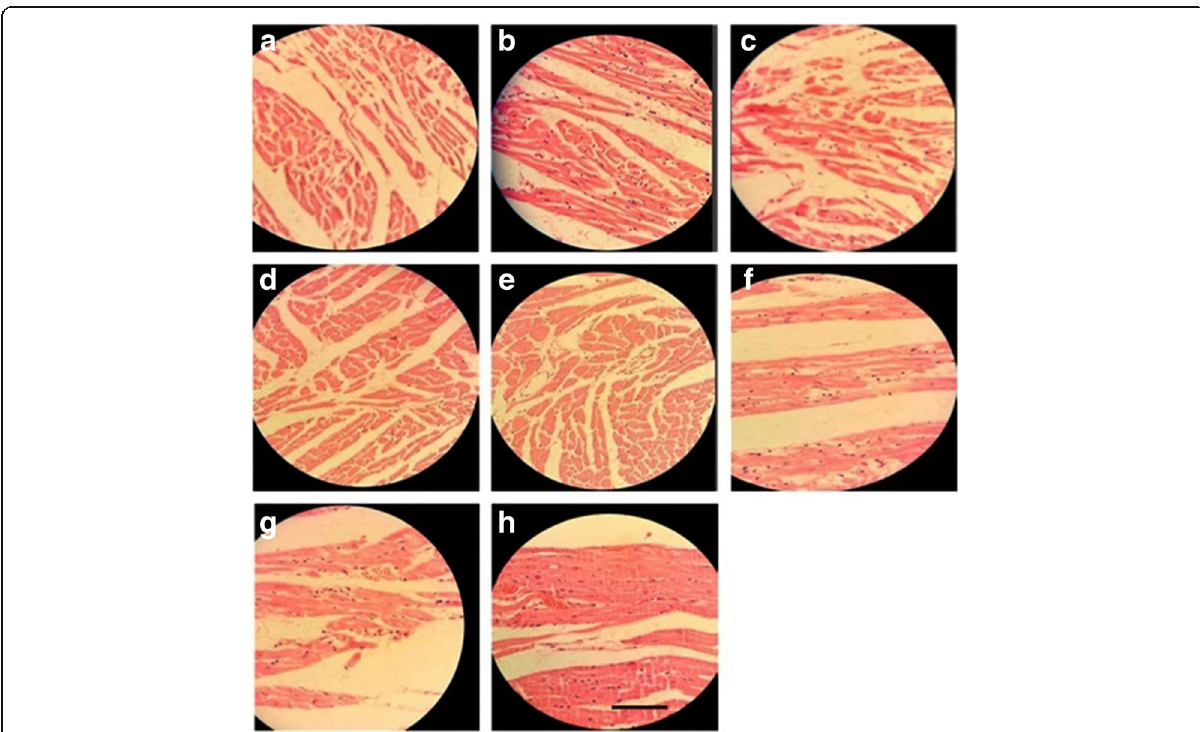
Fig. 7 Histopathological changes in the heart; a : Group I = Normal control, b : Group II = Diabetic wound control, c : Group III = Diabetic wound control +100 mg ethanolic extract of E. hirta , d : Group IV = Diabetic wound control +200 mg ethanolic extract of E. hirta , e : Group V = Diabetic wound control +400 mg ethanolic extract of E. hirta , f : Group VI = Diabetic wound control +5% Povidone iodine, g : Group VII = Diabetic wound control +5% ethanolic extract of E. hirta , h : Group VIII = Diabetic wound control +10% ethanolic extract of E. hirta . Each group was assessed at 400X magnification, scale bar: 40 μ m